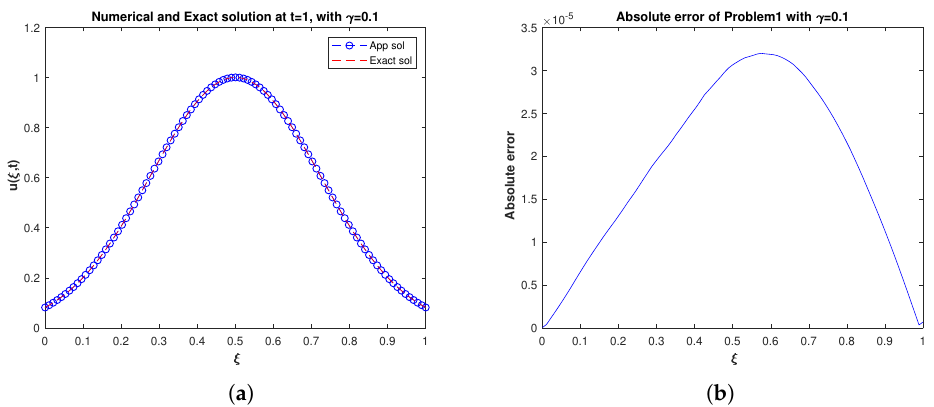
Figure 1. ( a ) The approximate and analytic solutions of Problem 1 with γ = 0.1, α = 0.8, N = 95, M = 24, and n = 10, at t = 1. ( b ) Plot of absolute error of Problem 1 with γ = 0.1, α = 0.8, N = 95, M = 24, and n = 10, at t = 1.